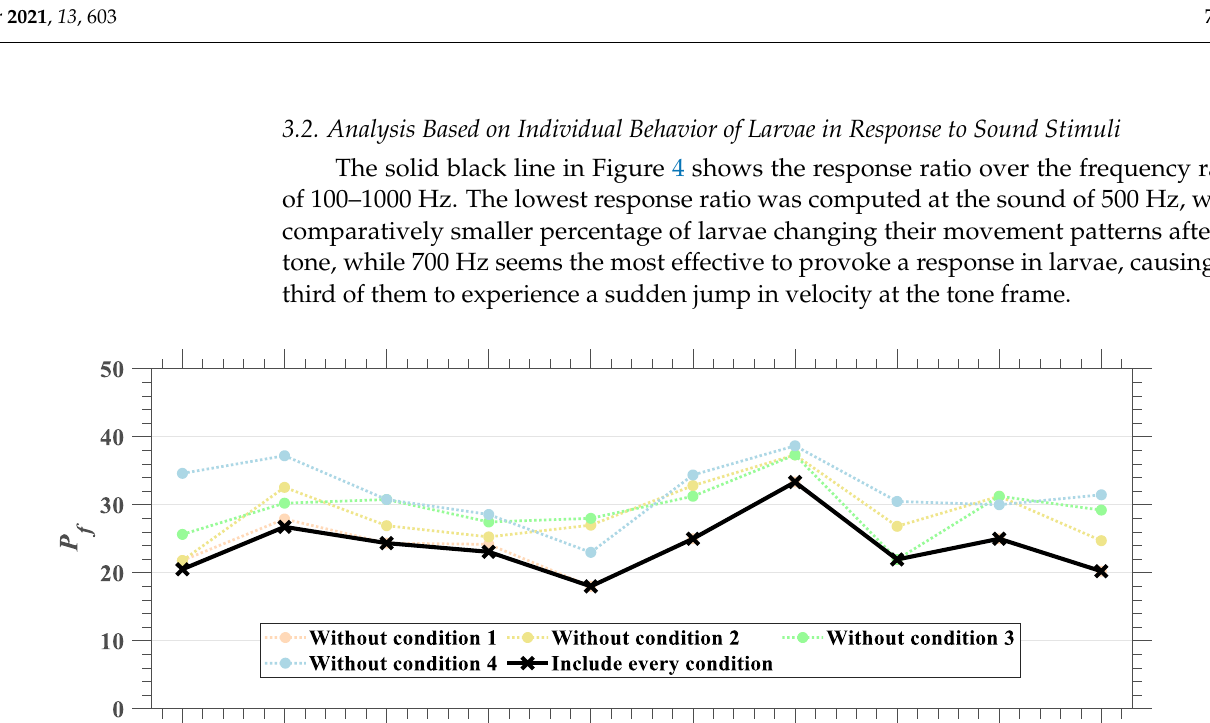
r = 0.98, r = 0.77, r = 0.65 1 2 3